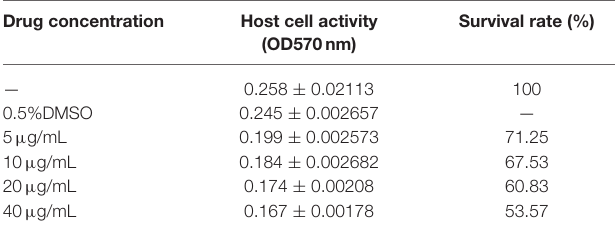
TABLE 1 | Effect of Act D on the hostcell survival rate.